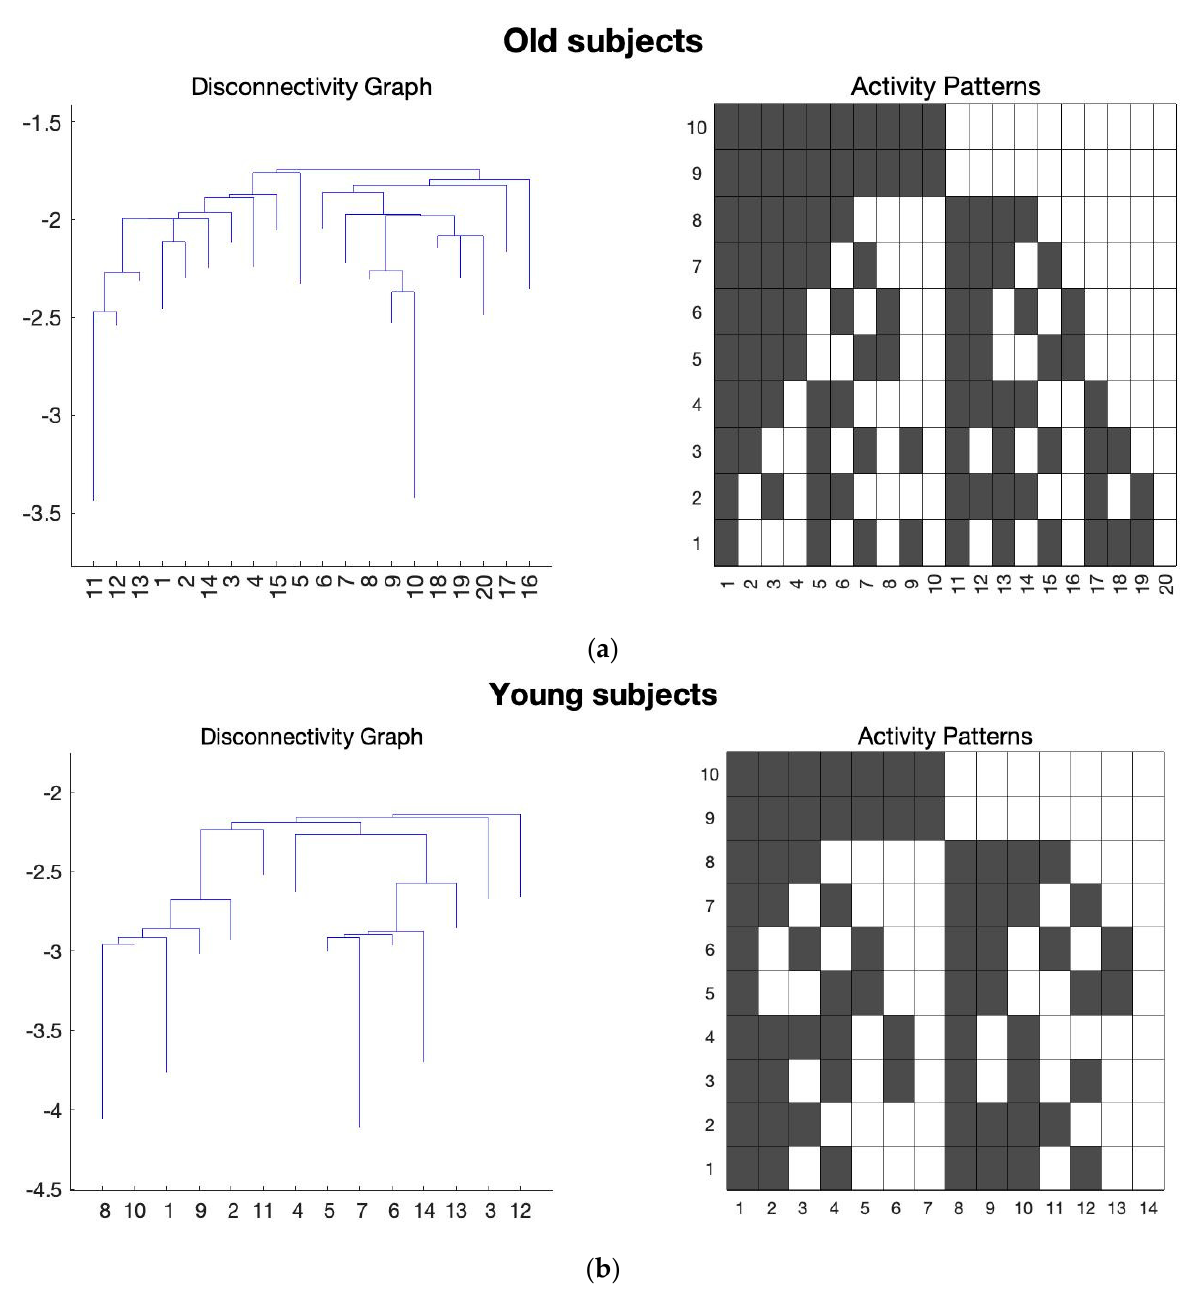
Figure 3. The average of all the subjects for the ATN was taken and the energy landscape analysis was conducted to generate the disconnectivity graph and activity pattern. Here, the x -axis of the disconnectivity graph represents the local minima number and y -axis shows its corresponding energy value. For the activity patterns, x -axis is the local minima number and y -axis shows the ROIs for ATN. ( a ) Energy landscape analysis conducted on the average of the old subjects for ATN. ( b ) Energy landscape analysis conducted on the average of the young subjects for ATN.